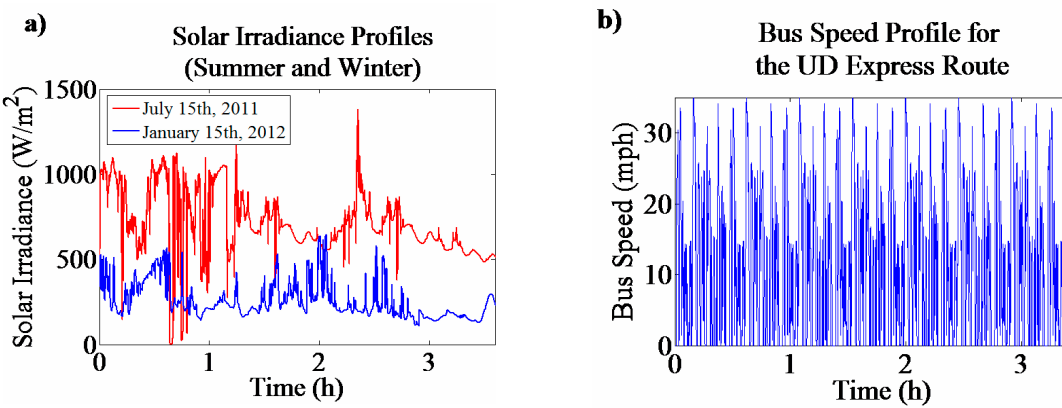
data used to simulate typical bus traction power